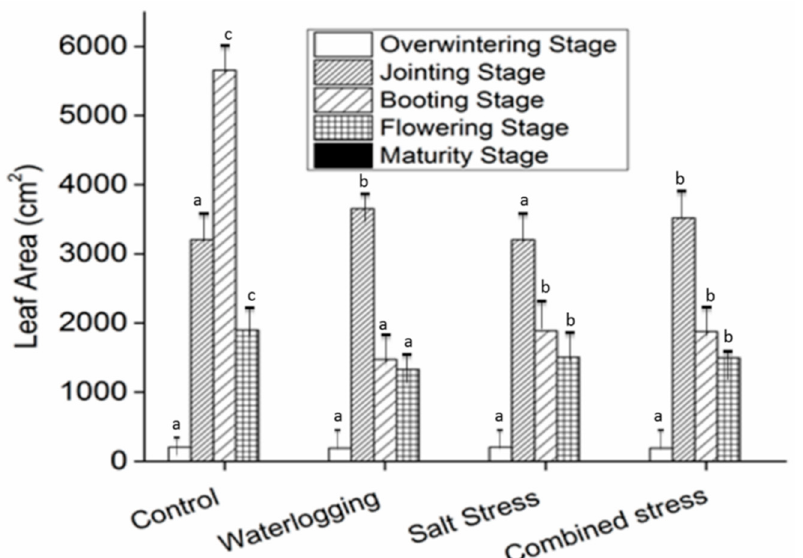
Figure 3. Leaf area of wheat plants during the five-stage plant growth (until flowering stage) grown under different abiotic stresses. Reported values are the means and standard deviations of triplicates for each treatment. Note: sampling date at overwintering stage was 28 December 2020; at jointing stage was 12 March 2021; at booting stage was 30 March 2021; at the flowering stage was 17 April 2021; and at maturity stage was 28 May 2021. Lowercase letters show the significant differences among treatments according to one-way ANOVA and DMRT, while the significance level was p ≤ 0.05.